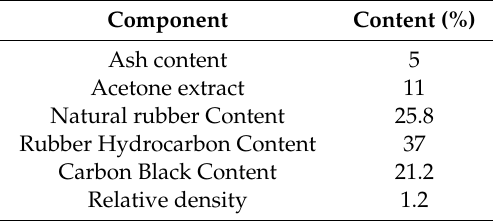
Table 2. Components and properties of crumb rubber modifier